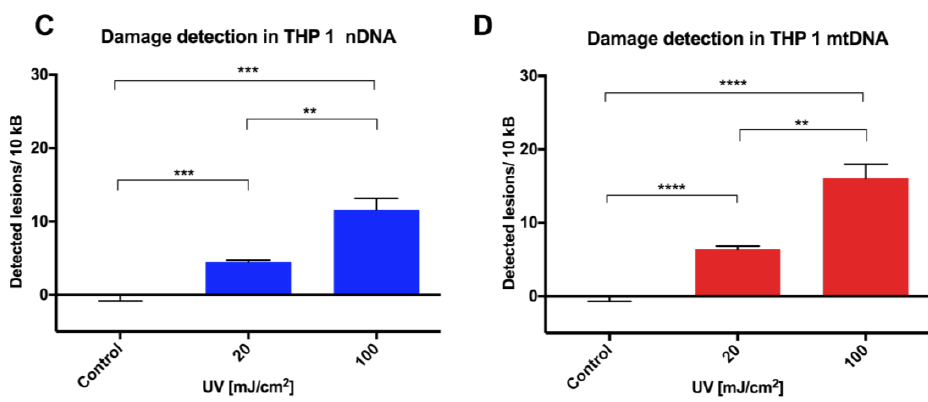
Figure 1. Nuclear DNA (nDNA) and mitochondrial DNA (mtDNA) damage quantitation in cancer cell lines. Genotoxic stimulation with UVC (20 or 100 mJ/cm 2 ) was assessed in adherent A549 cells in ( A ) nDNA and ( B ) mtDNA, and in the THP1 suspension cell line in ( C ) nDNA and ( D ) mtDNA using qPCR ( n = 5). Results are presented as mean ± SE. ** p <0.01, *** p < 0.001, **** p <0.0001.